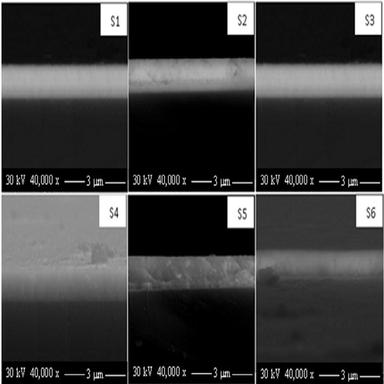
The FESEM cross sectional images of the Bi2Te3 thin films as-deposited and annealed in vacuum and N2 atmosphere.